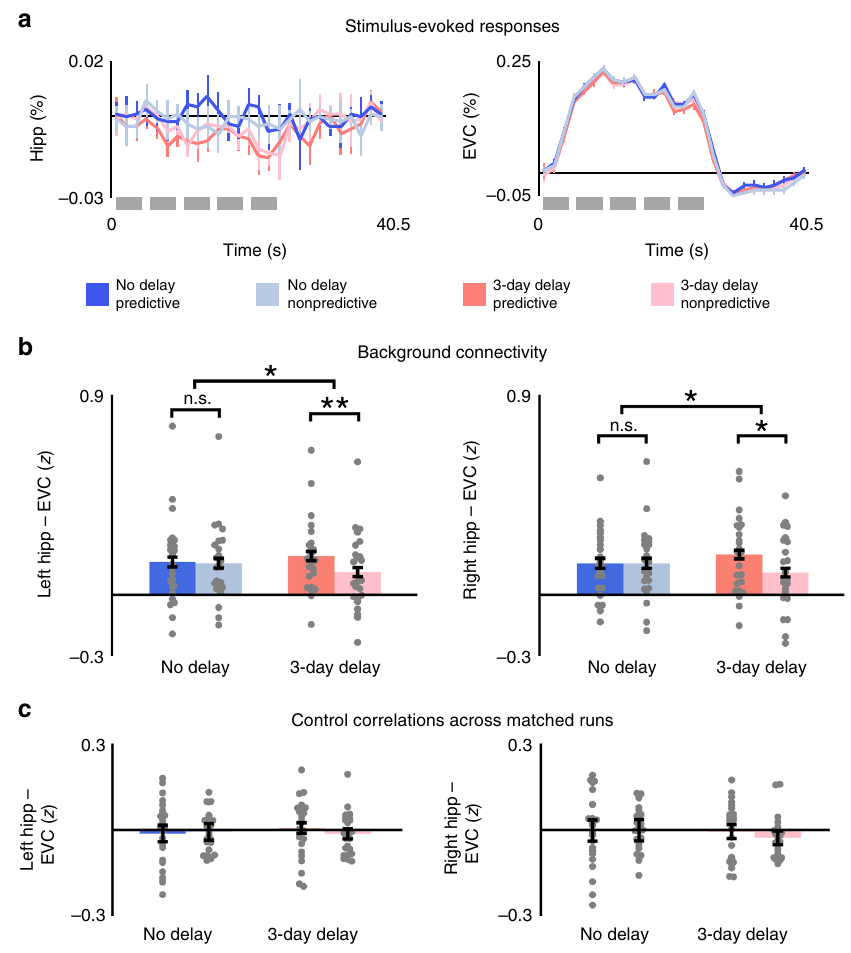
Fig. 2 Stimulus-evoked responses and background connectivity. a Within each ROI, stimulus-evoked BOLD activity was similar during blocks of predictive and nonpredictive actions, both immediately after training and 3 days after training. Each block contained fi ve trials (gray bars). b For both left and right hippocampus, background connectivity with EVC was stronger for predictive vs. nonpredictive actions 3 days after training but not immediately after training. c Control correlations across runs with matching stimuli and timing did not differ between any of the conditions. Error bars indicate ± 1 SEM of the difference between predictive and nonpredictive actions at each timescale. ** p < 0.01; * p < 0.05 (paired t -tests). Source data are provided as a Source Data fi